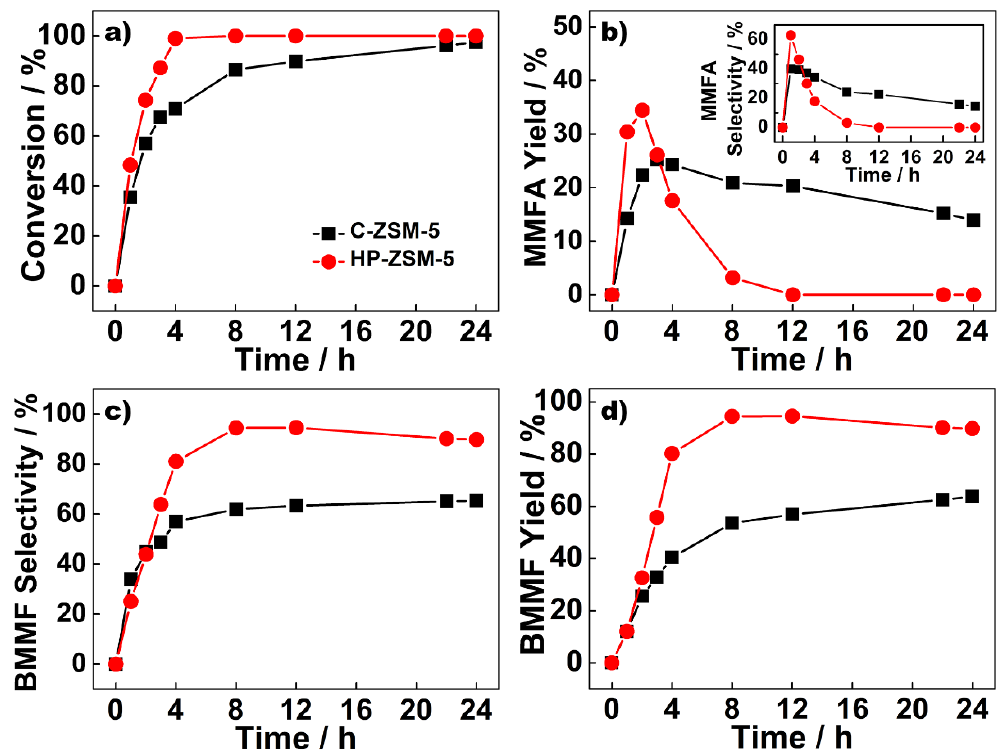
Figure 1. Etherification of 2,5-bis(hydroxymethyl)furan (BHMF) with methanol over C-ZSM-5 and HP-ZSM-5. Reaction conditions: 10 g·L −1 BHMF, 10 g·L −1 catalyst, 65 °C, 24 h.